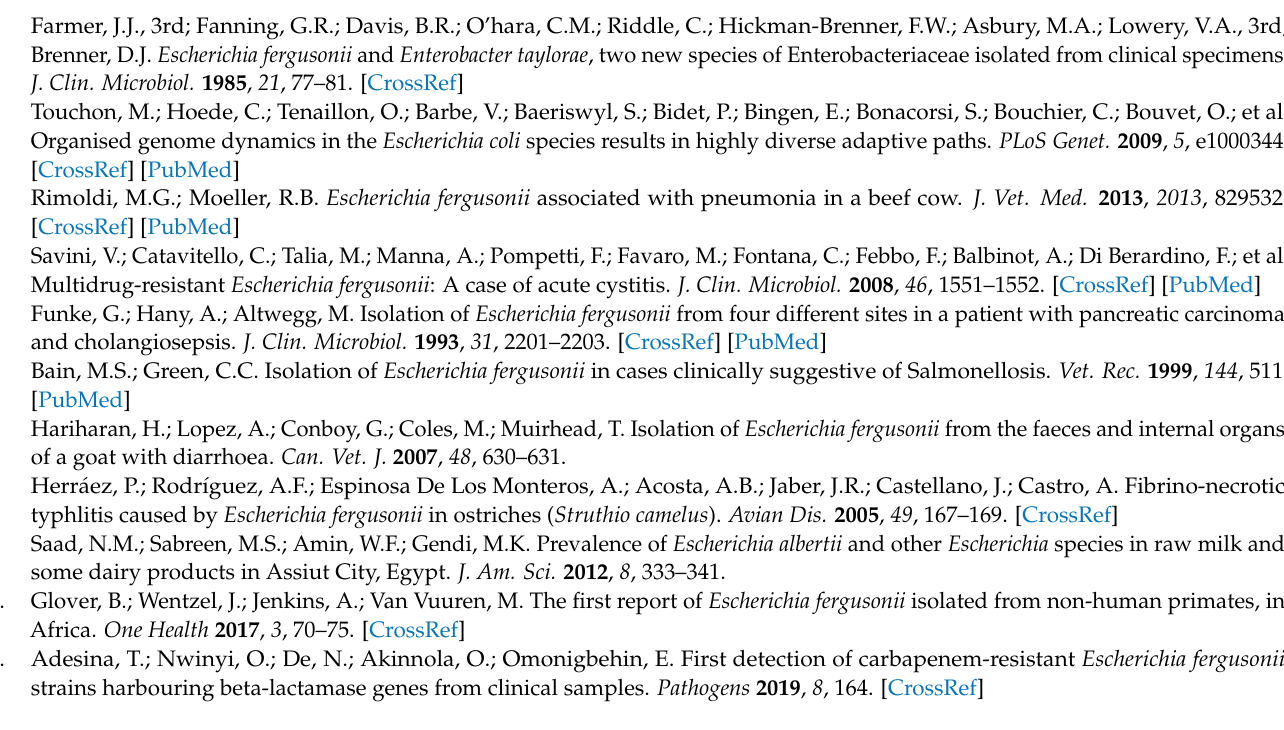
presence of essential oils of black pepper (BPE) and cinnamon extracts (CE) at different concentrations at 25 ◦ C for 24 h. Concentrations are in % ( w / v ), values are the mean of three individual replicates (means ± SD). Figure S8. Growth of S. thermophilus in fermenting milk in the presence of essential oils of black pepper (BPE) and cinnamon extracts (CE) at different concentrations at 43 ◦ C for 24 h. Concentrations are in % ( w / v ), values are the mean of three individual replicates (means ± SD). Figure S9. Growth of S. thermophilus in fermenting milk in the presence of essential oils of black pepper (BPE) and cinnamon extracts (CE) at different concentrations fermented at 25 ◦ C for 24 h. Concentrations are in % ( w / v ), values are the mean of three individual replicates (means ± SD). Figure S10. Growth of S. thermophilus in fermenting milk in the presence of essential oils of black pepper (BPE) and cinnamon extracts (CE) at different concentrations during storage at 25 ◦ C after fermentation at 43 ◦ C for 24 h. Concentrations are in % ( w / v ), values are the mean of three individual replicates (means ± SD). Figure S11. Survival of S. thermophilus during subsequent storage at 25 ◦ C of the milk fermented at 25 ◦ C for 24 h subsequently incorporated with black pepper extract (BPE) combined with cinnamon extract (CE) at different concentrations. Concentrations are in % ( w / v ), values are the mean of three individual replicates (means ± SD). Figure S12. Survival S. thermophilus during subsequent storage at 25 ◦ C of the milk fermented at 43 ◦ C for 24 h then incorporated with black pepper (BPE) and cinnamon extracts (CE) at different concentrations. Concentrations are in % ( w / v ), the mean of three individual replicates (means ±